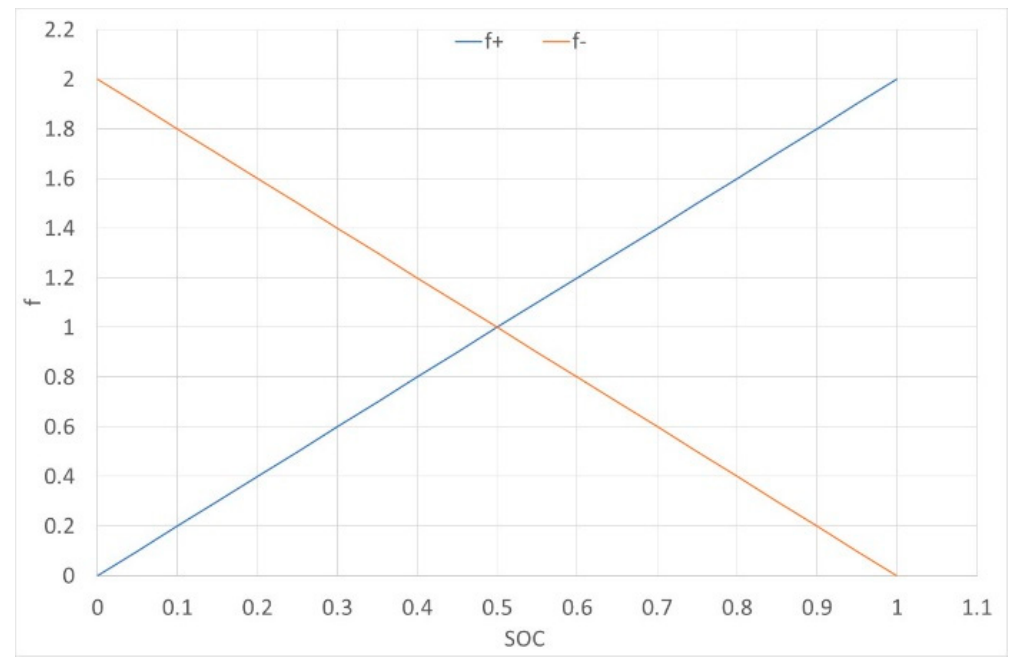
Figure 13. Functions curve for the State of Charge.